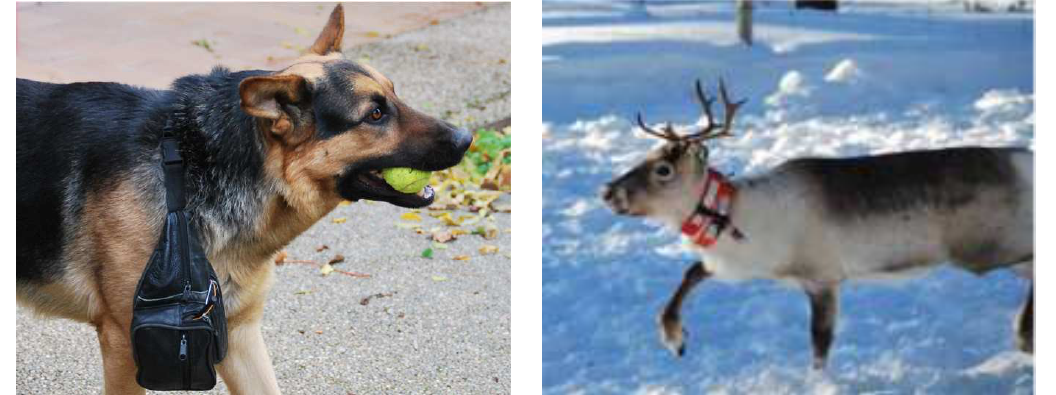
Figure 10. A secondary node (a) in a hip bag around a dog neck in an Spanish courtyard and (b) mounted on a reflective collar around a reindeer neck in Northern